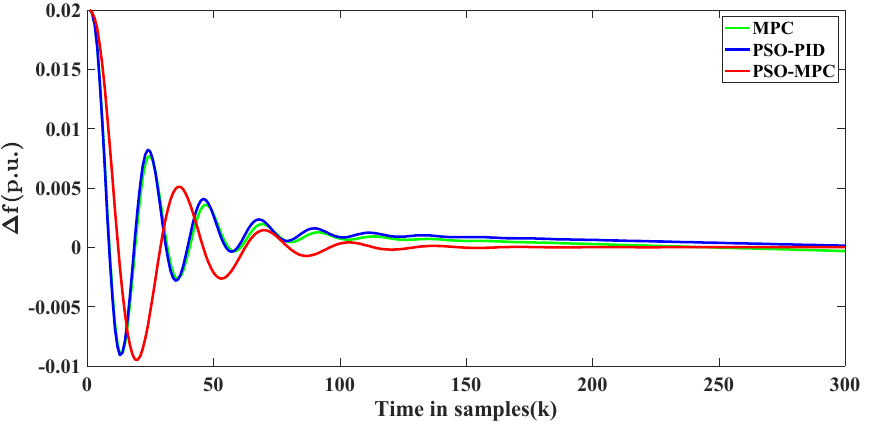
Figure 11. Dynamic response curve of the load frequency deviation under the three strategies with